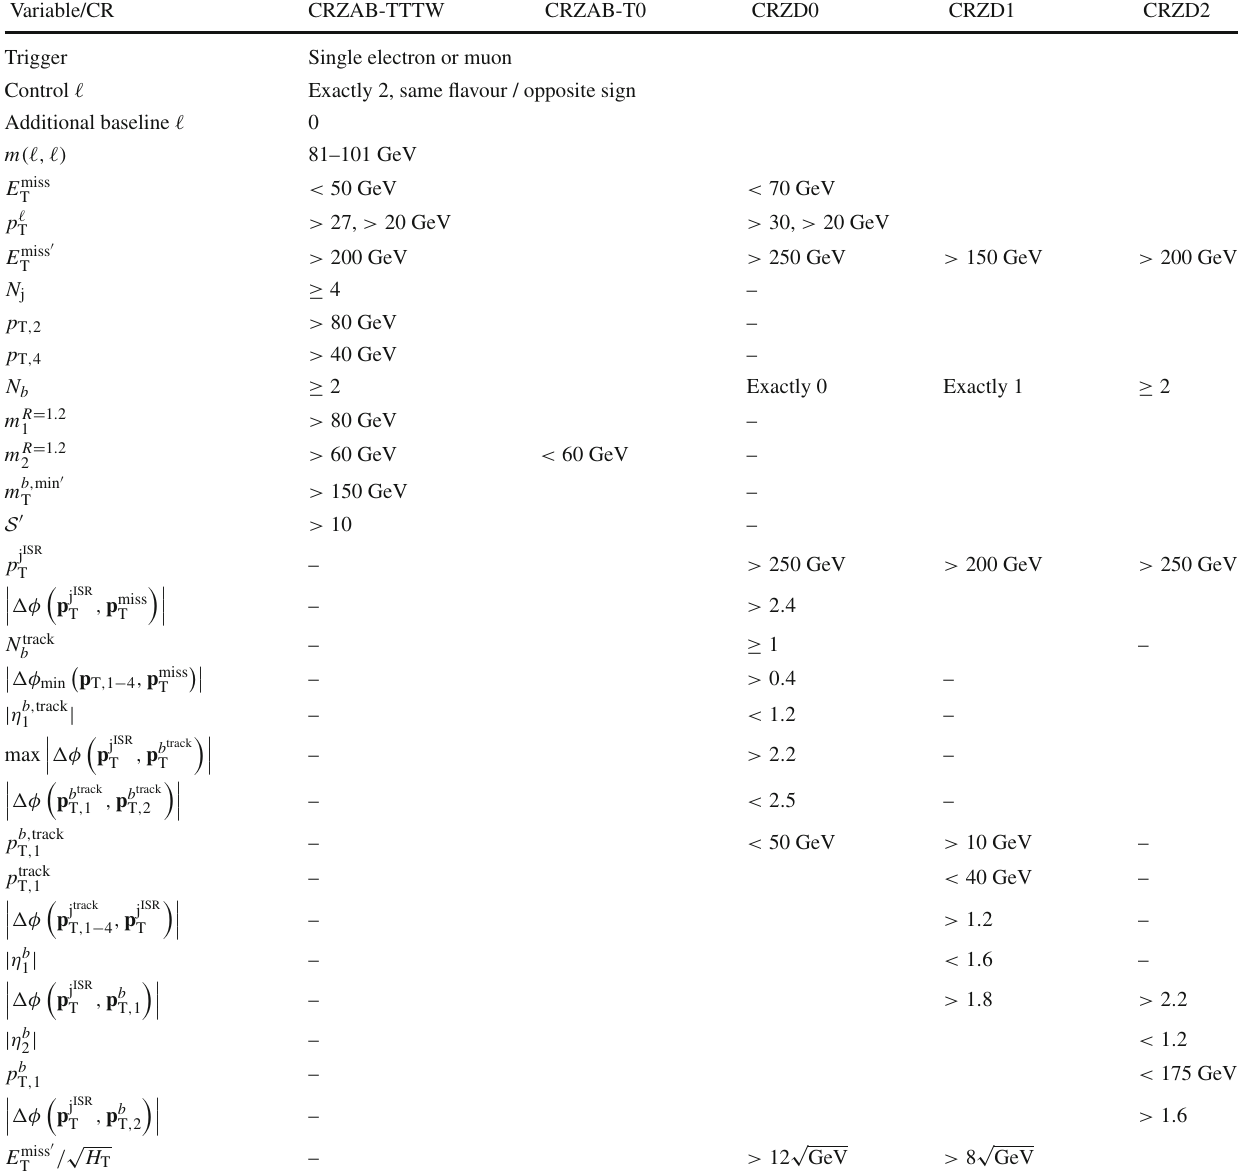
Table 5 Selection criteria for the Z + jets control regions. The defining extrapolation for these control regions is over the number of leptons; two electrons or muons ( (cid:13) ) from Z decays are required, compared with zero leptons in the signal regions. A dash indicates that no selection is applied. Variables for which the signal and control region requirements